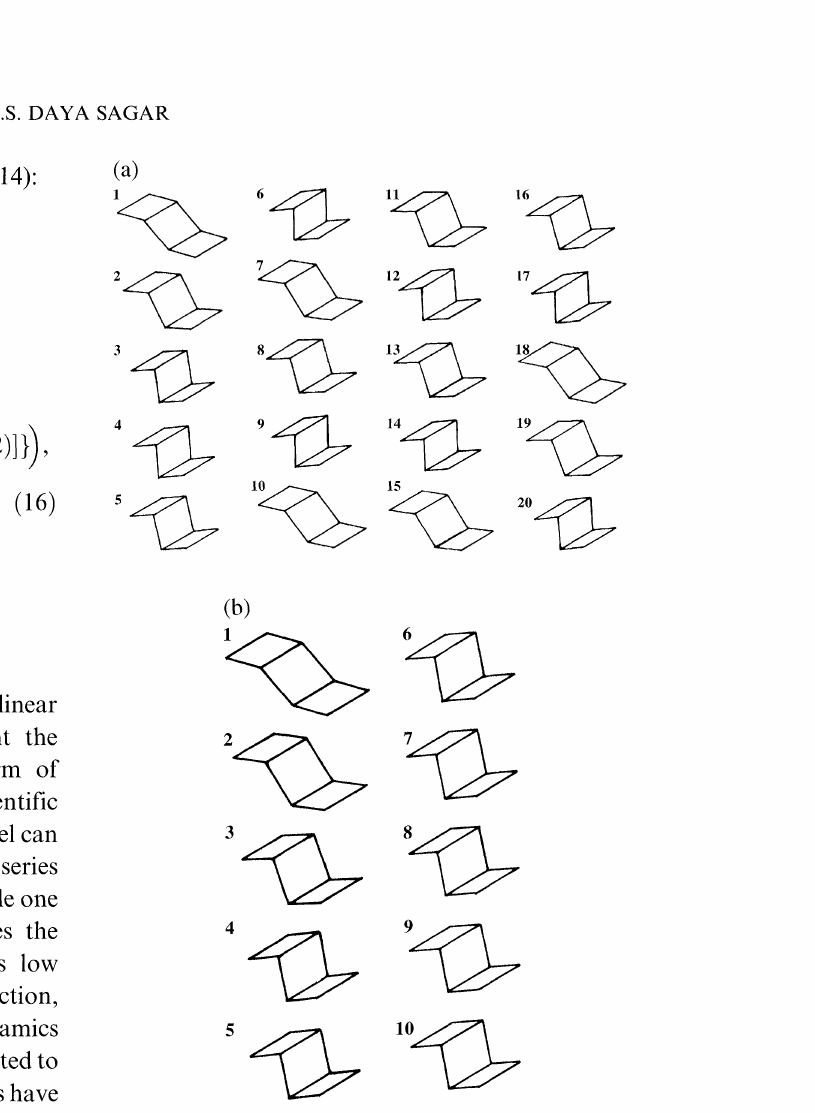
FIGURE 3 Evolution of a fold type with strength of non- linearities (a) A=0.975 and (b) k=0.7. The numbers repre- sent the discrete